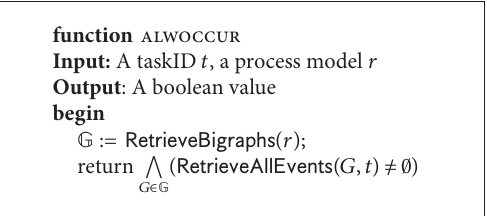
Algorithm 7: Determining the (unary) basic predicate alwoccur